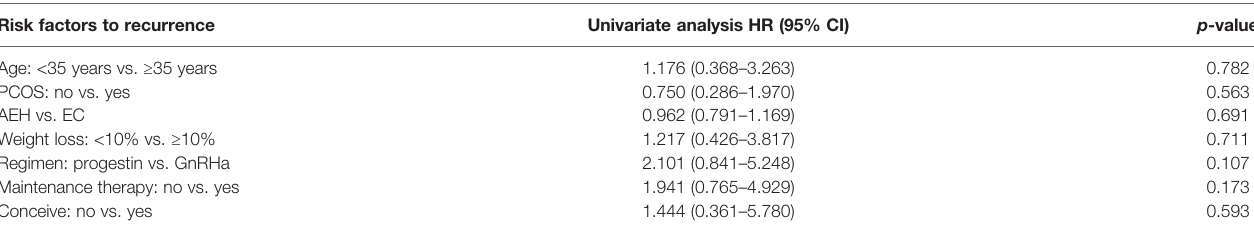
TABLE 5 | Predictors of recurrence.